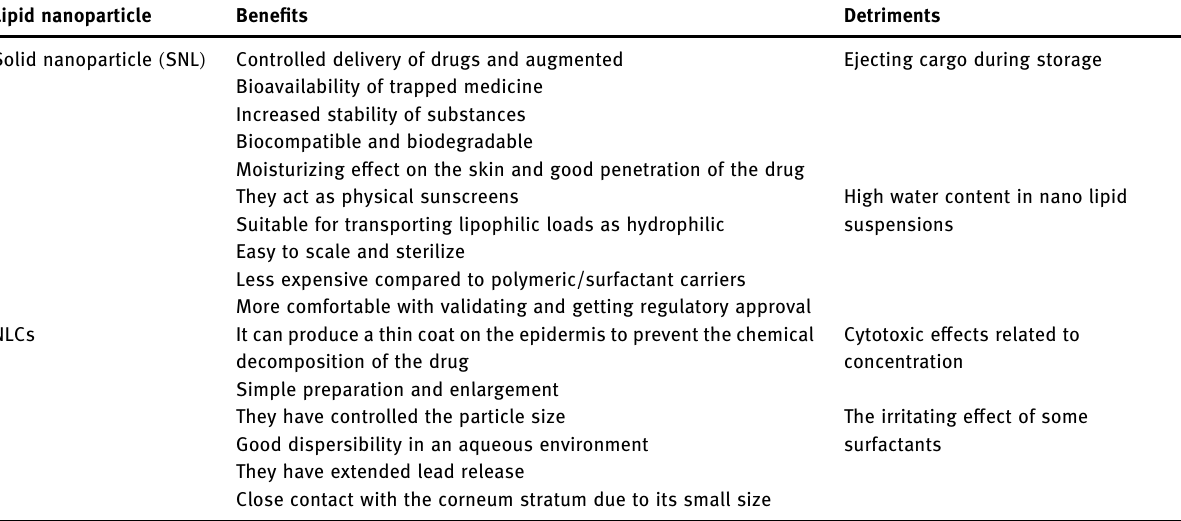
Table 5: Bene fi ts and detriments of SLNs [ 15 ] Lipid